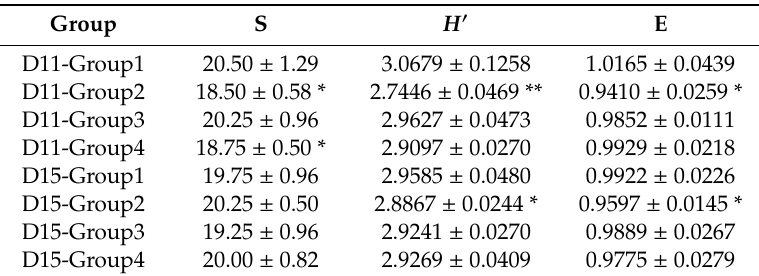
Table 2. Microflora diversity indexes